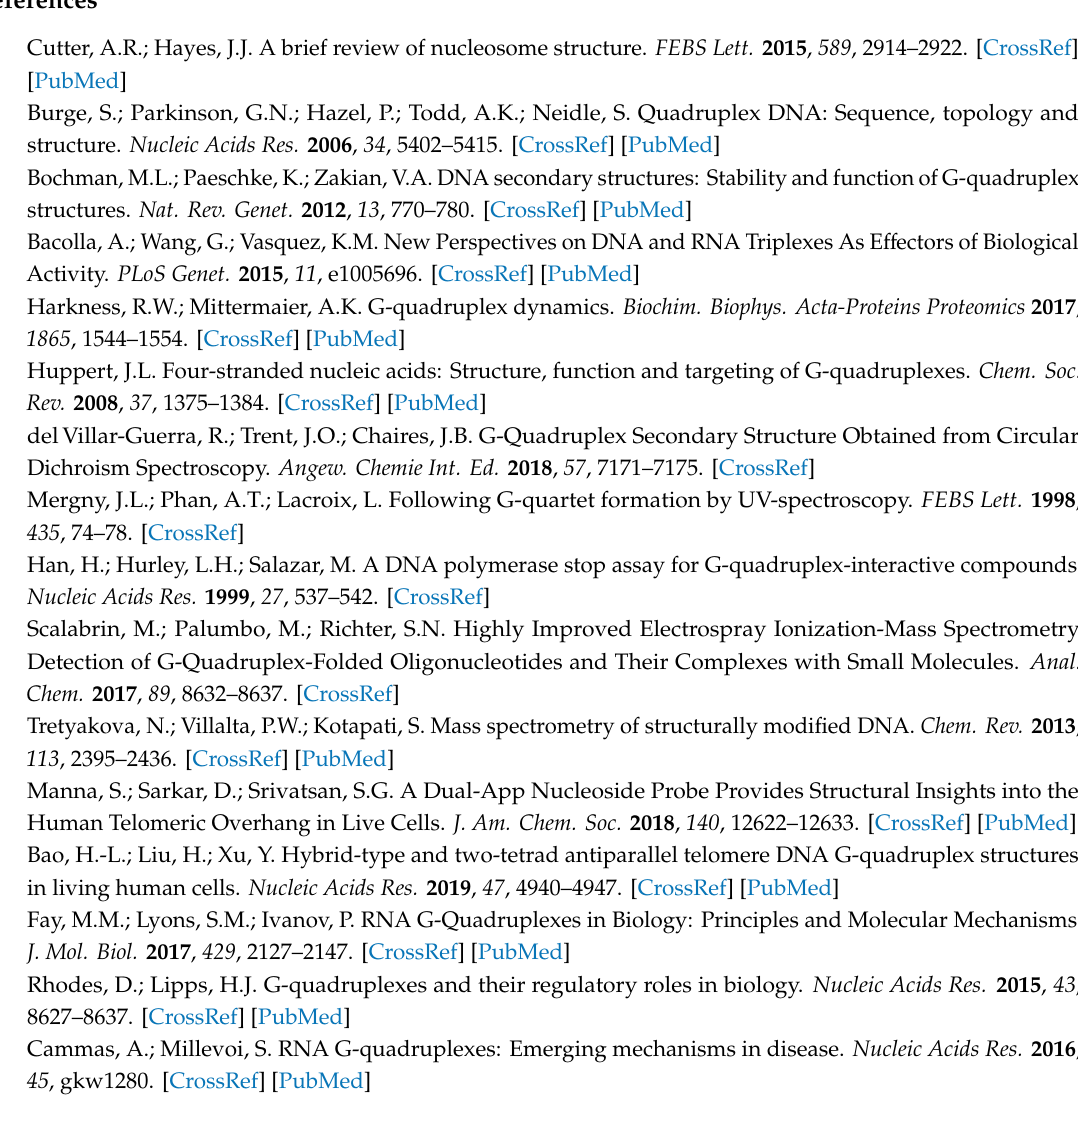
Supplementary Materials: The following are available online, Figure S1: CD thermal unfolding spectra, CD thermal unfolding fitting and TDS of Alphaherpesvirus IE promoter G4 sequences, Table S1: Oligonucleotides used in the Taq polymerase stop